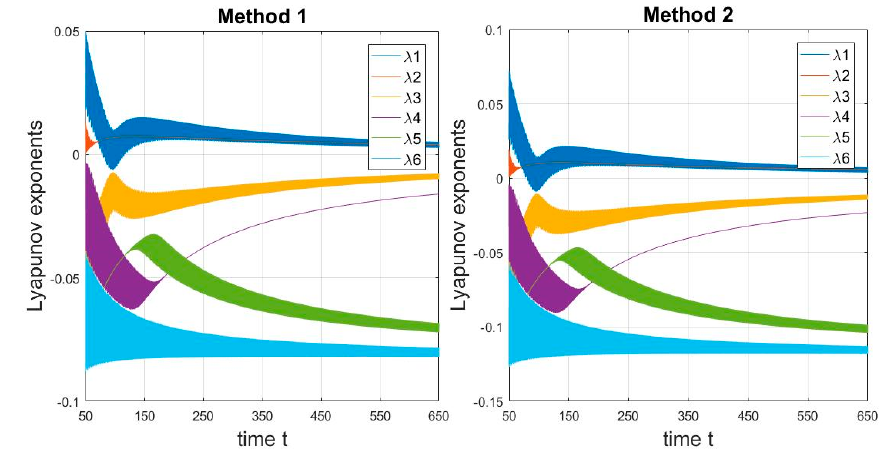
Figure 13. Time history of Lyapunov exponents starting at t = 50 for C = 0.05, k = 40, ω = 2.84 .